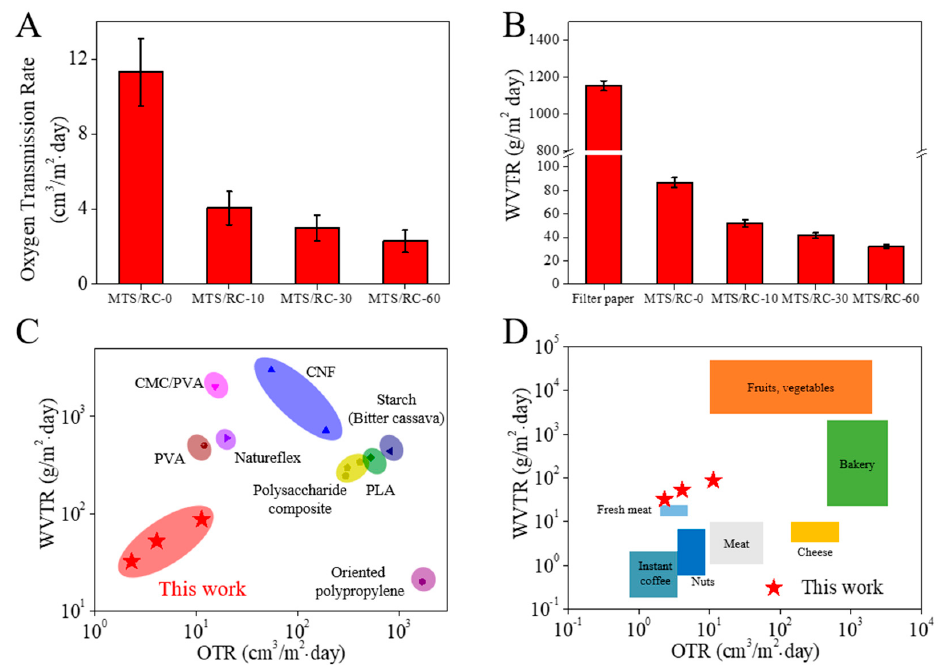
Figure 7. ( A ) OTR values and ( B ) WVTR values for the filter paper, pristine RC film, and MTS/RC films for various MTS reaction times. ( C ) Comparison of the OTR and WVTR of the reported food packaging films and MTS/RC films (red stars). ( D ) OTR and WVTR requirements for different food products and the OTR and WVTR of the MTS/RC films (red stars).